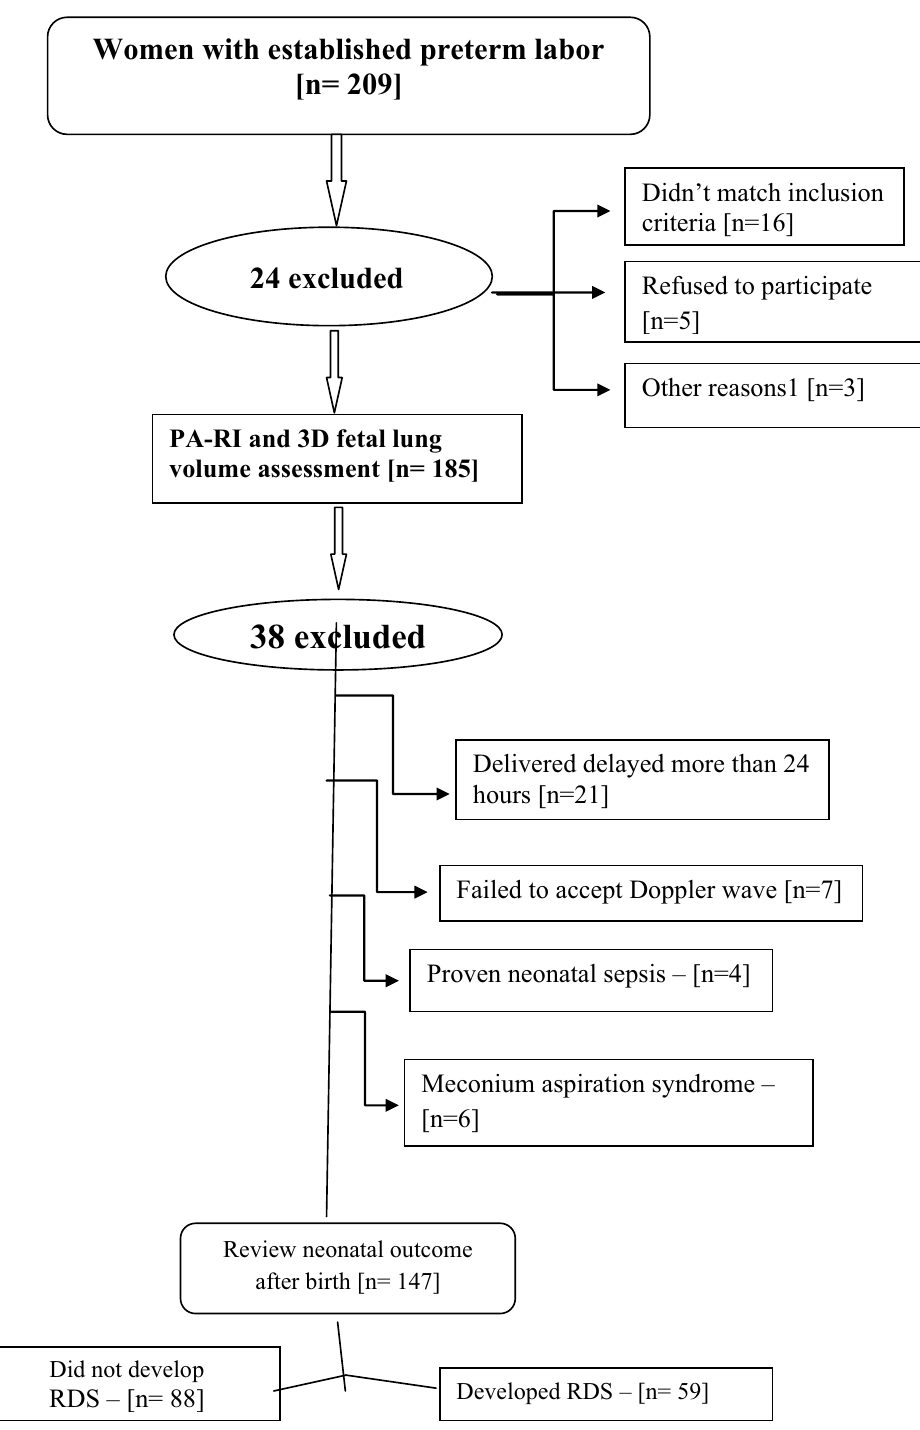
Fig. 1 The process of handling of the study